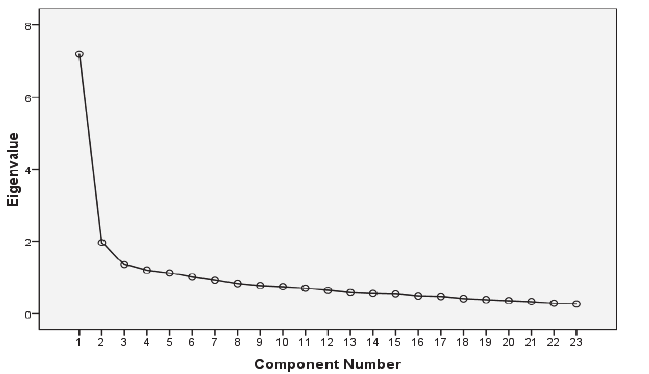
Fig. 2. The results of Scree